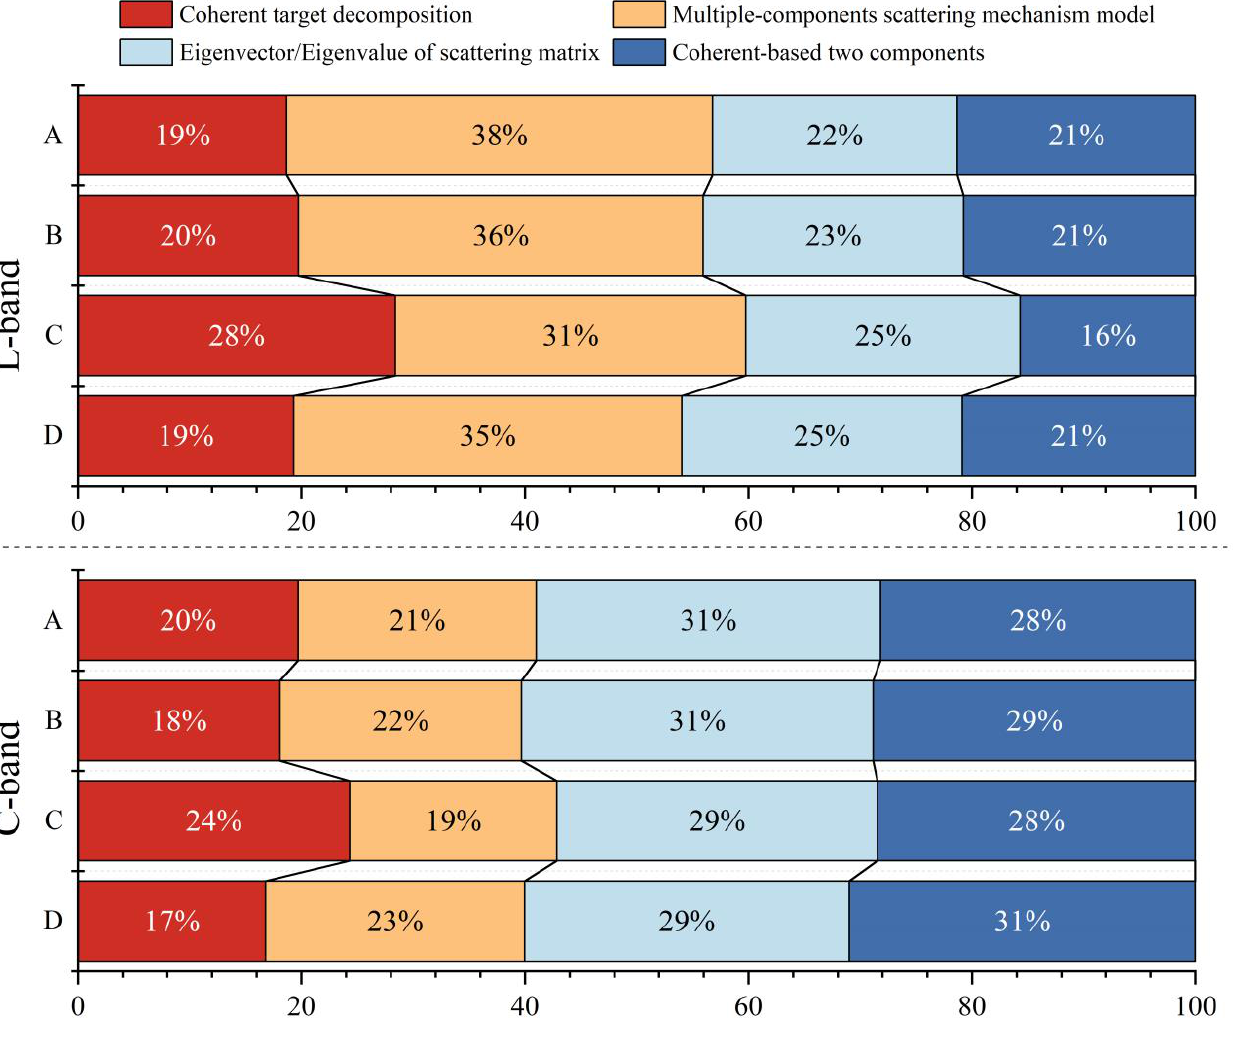
Figure 11. Contribution of polarimetric parameters to marsh vegetation classification using four polarimetric decomposition methods. A, shrub, B, forest, C, deep-water marsh vegetation, D, shallow-water marsh vegetation.